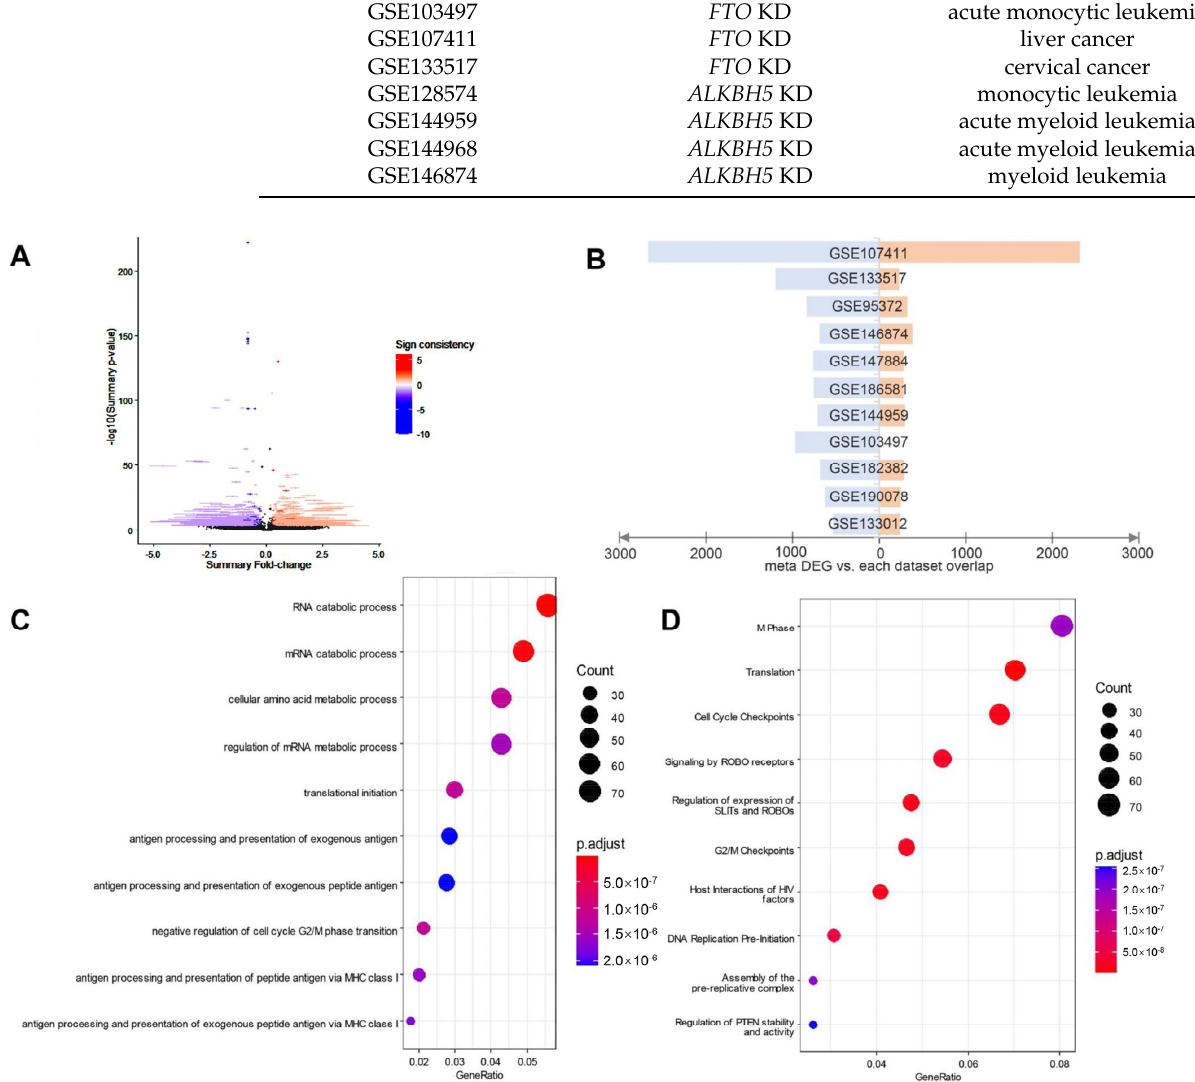
Figure 1. Overview of the m6A ‐ related consensus differentially expressed genes (DEGs). ( A ) Vol ‐ cano plot of meta ‐ analysis. ( B ) Coincidence number of DEGs in individual datasets. ( C ) GO enrichment analysis of the consensus DEGs from meta ‐ analysis. ( D ) Reactome pathway analysis of the consensus DEGs from meta ‐ analysis.